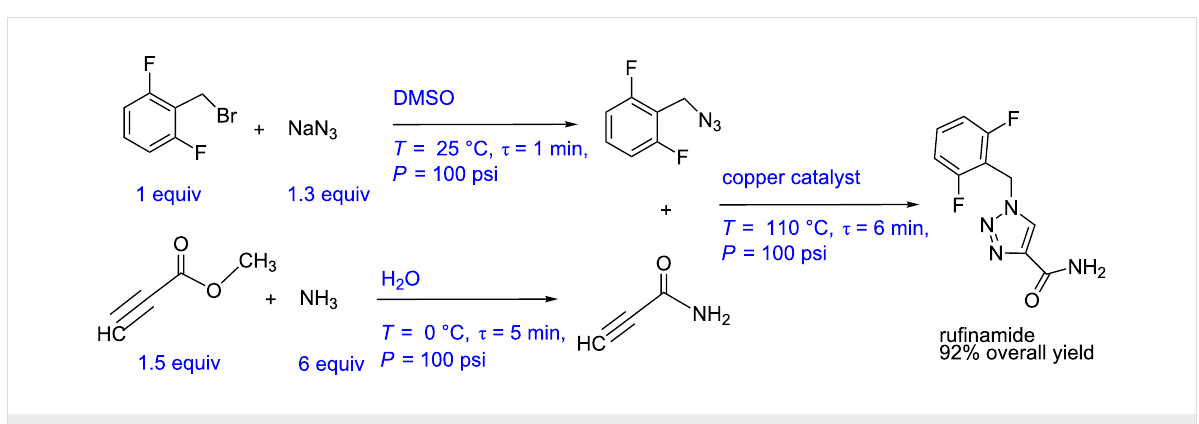
Scheme 3: Multistep flow synthesis of rufinamide (Zhang et al.